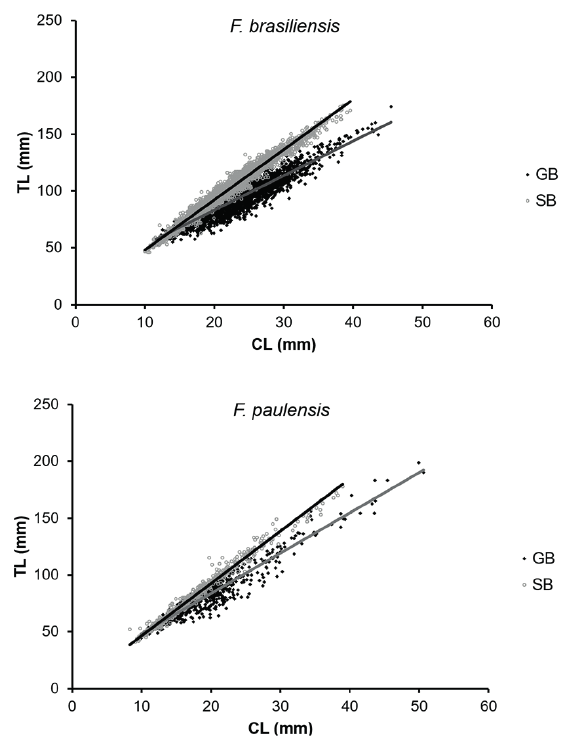
Figure 2 - linear regressions (total length-carapace length relationship) for F. brasiliensis and F. paulensis. Black crosses = guanabara Bay shrimps; grey circles = Sepetiba Bay shrimps. Tl = total length (mm); Cl = carapace length (mm); gB = guanabara Bay; SB = Sepetiba